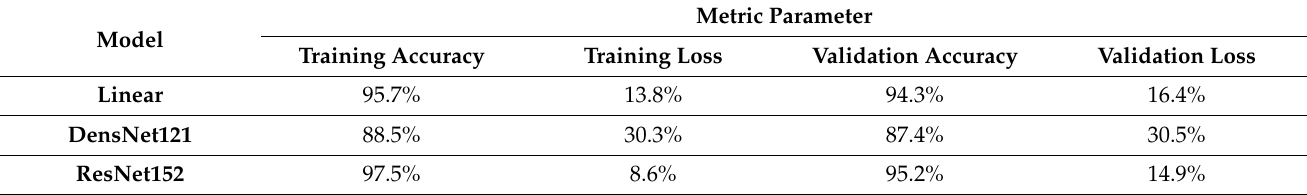
Table 2. Comparison between linear, DenseNet121, and ResNet152